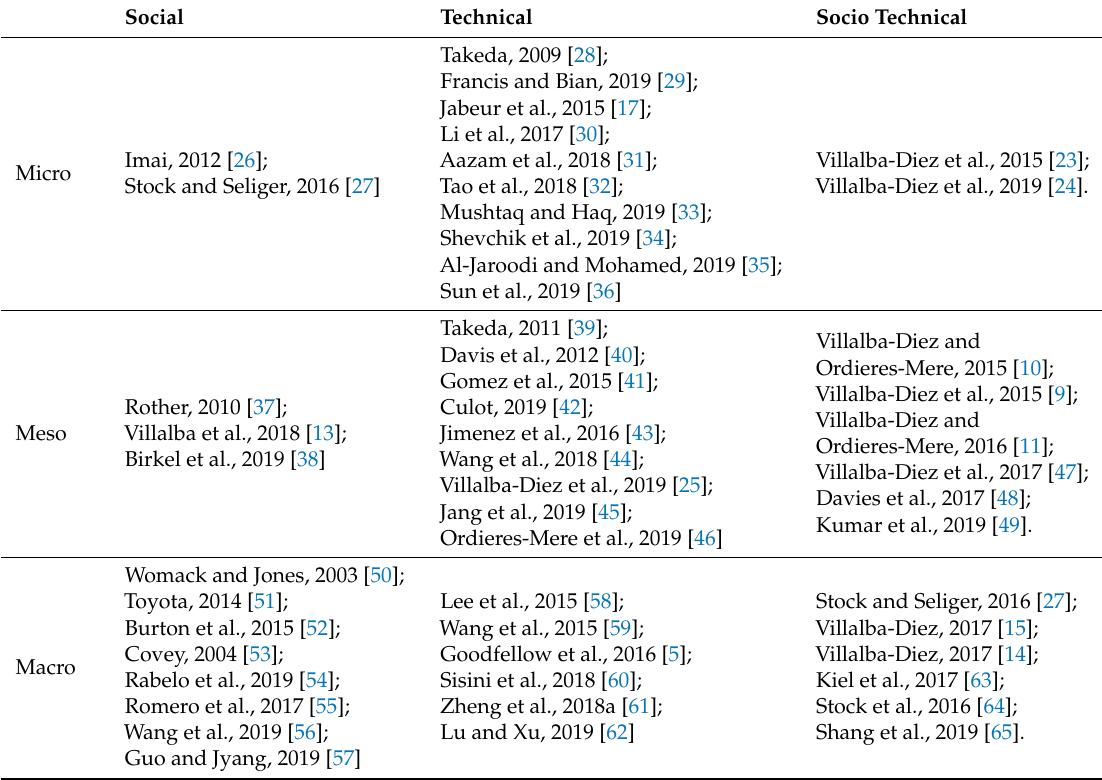
Table 1. Research